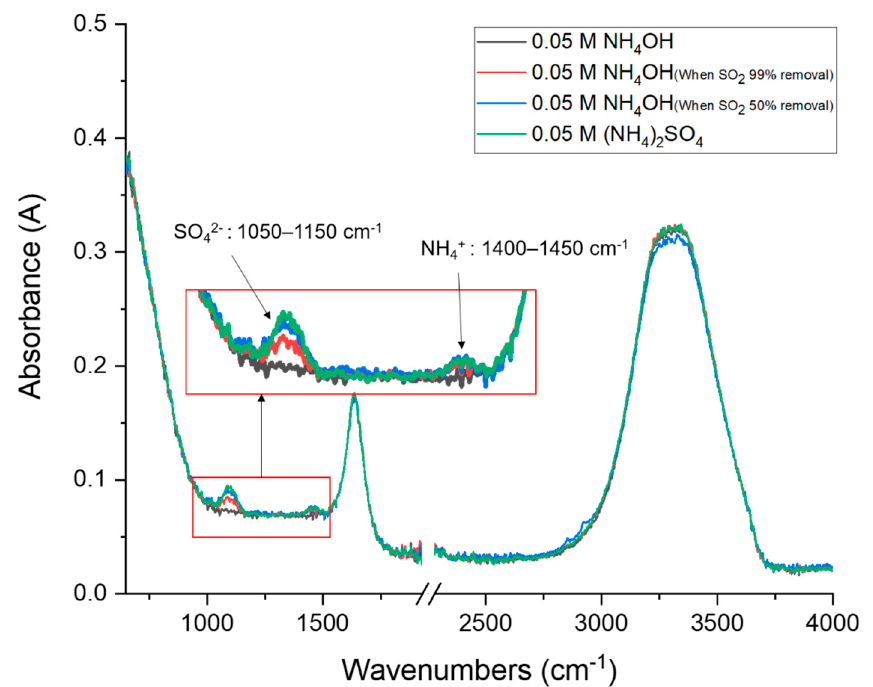
Figure 7. FTIR spectra of fresh and SO 2 absorbed aqueous NH 4 OH .